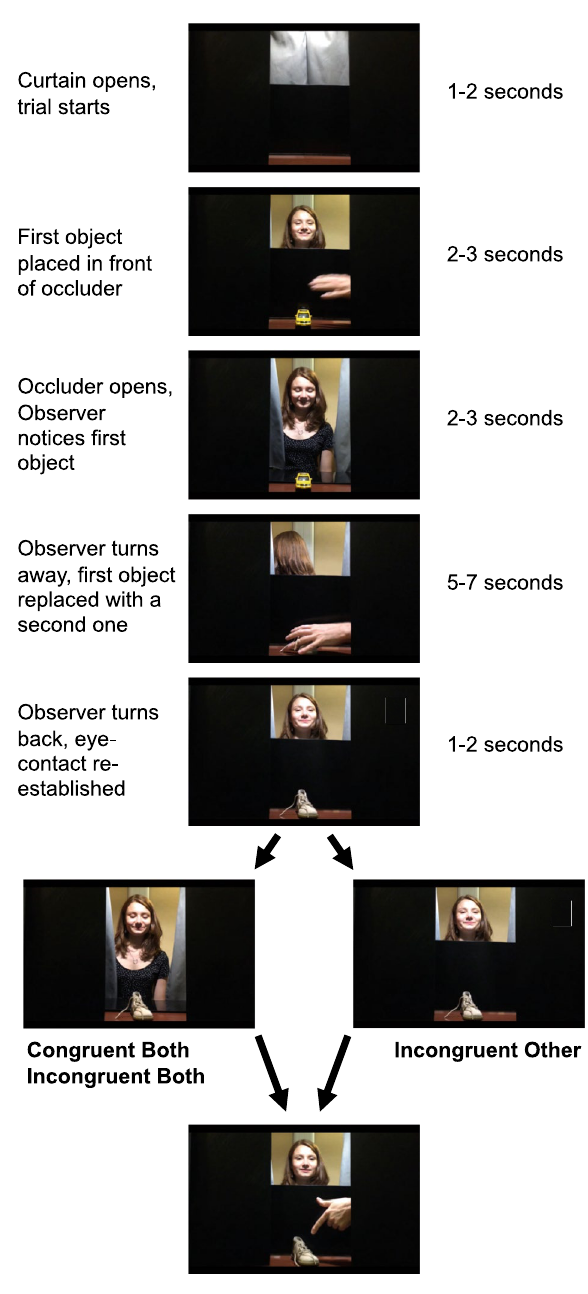
Figure 2. Experimental procedures of Experiments 3–5. The experimental paradigm was adapted from Forgács et al.’s studies 13,14 , and is described in detail in the Supplementary Procedures. In Incongruent-Other trials, due to an object change not visible for the Observer, the Observer held a false belief about the identity of the object being labeled, thereby she experienced a semantic incongruity. In the other two conditions the object change was revealed to the Observer by showing her the second object as well, and then objects were labeled either correctly (Congruent-Both) or incorrectly (Incongruent-Both). (Figure adapted from Forgács et al. 13 with minor modifications to describe the present